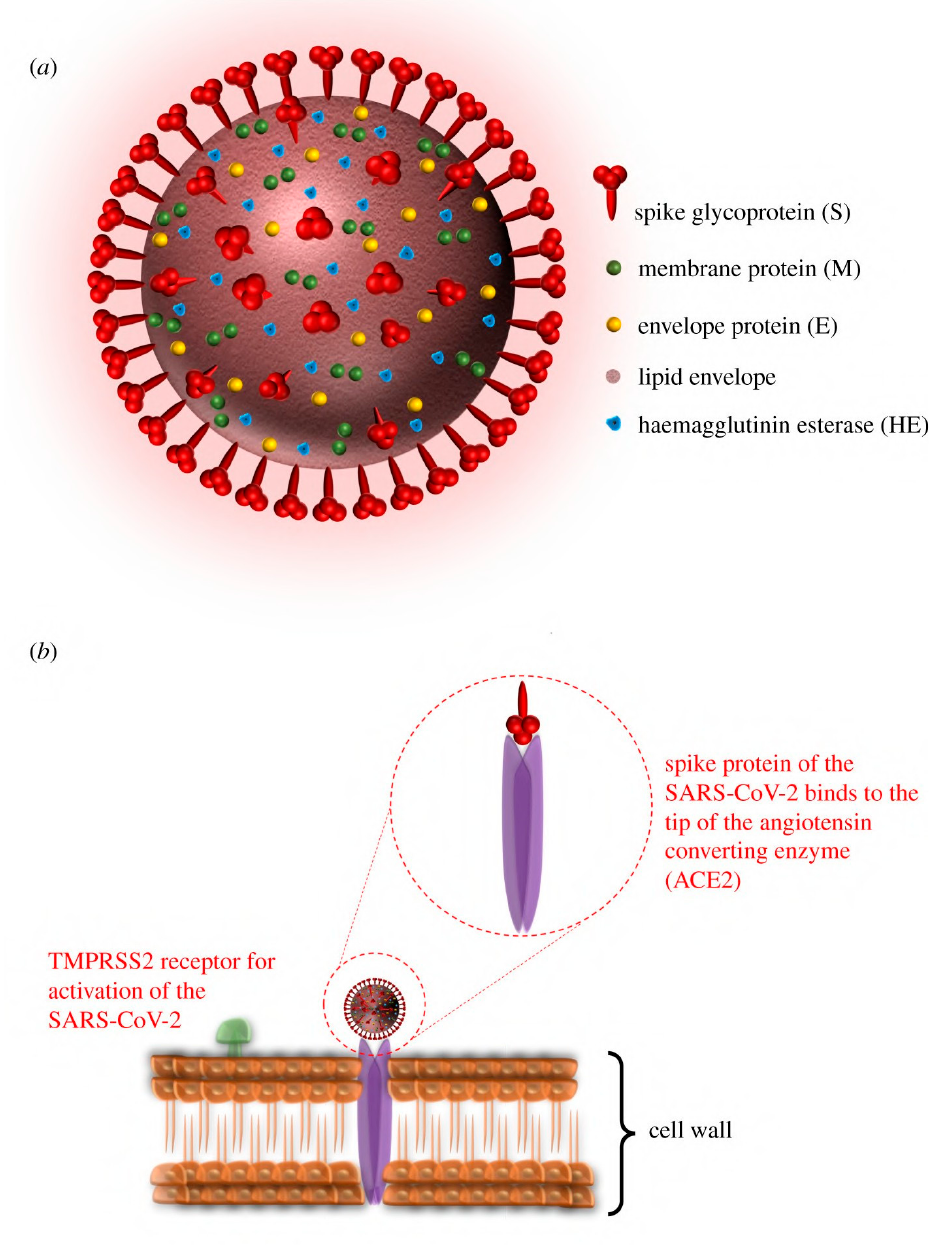
Figure 1. Illustration of ( a ) the structure and proteins of the coronavirus, and ( b ) the mechanism for cell entry via spike proteins (adapted with permission from Aydogdu et al. [10]). Viruses are capable of rapid mutation when they enter and proliferate within their host. The virus is transferred and propagated among humans by various routes,